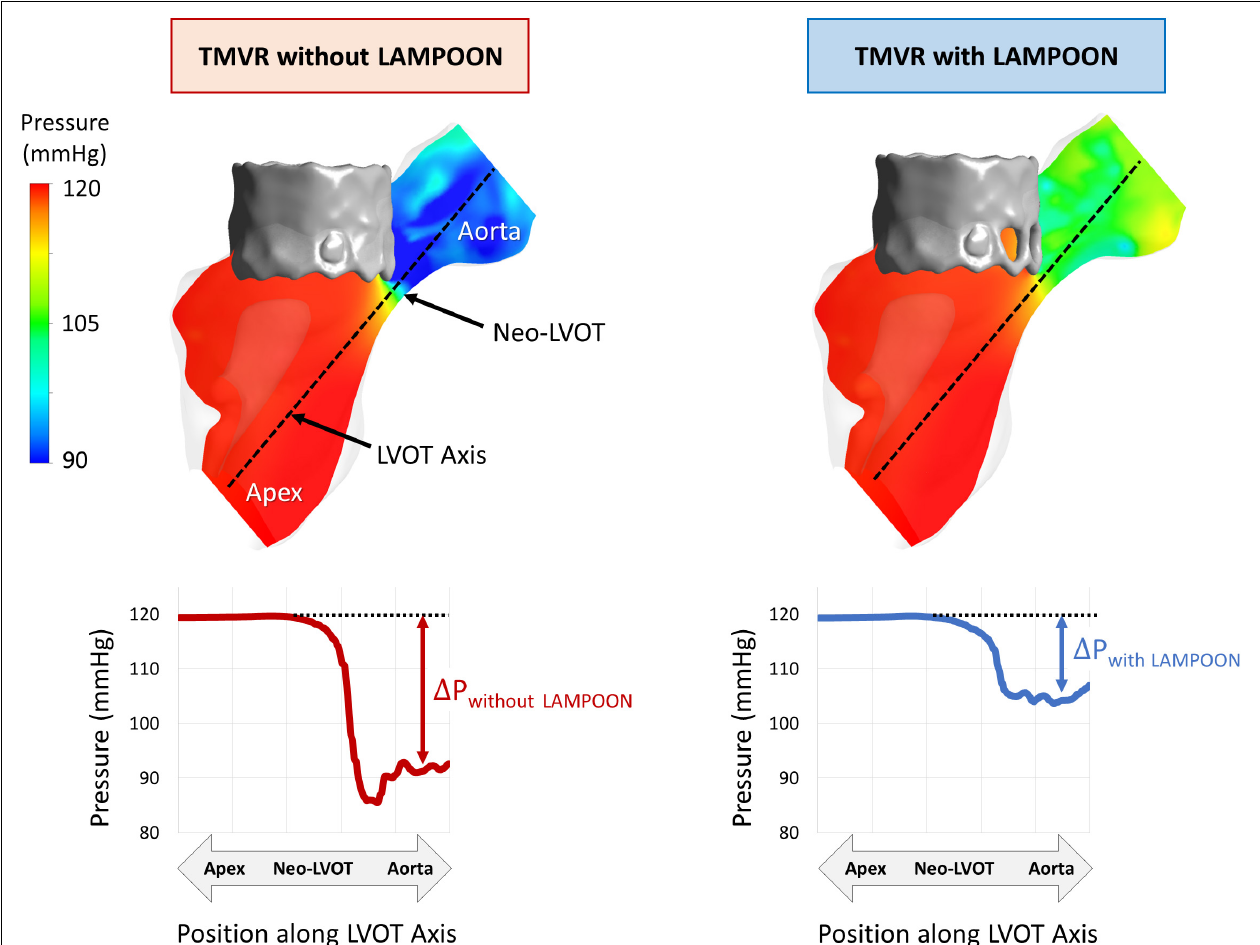
FIGURE 3 | Effect of LAMPOON on left ventricular pressure fields. Simulated pressure fields for a representative subject (Subject 5) are shown in color maps (red = highest pressure, blue = lowest pressure). The left column shows the simulated pressure drop at the LVOT for the virtual control procedure (TMVR without LAMPOON). The right column shows the simulated pressure drop at the LVOT for the actual performed procedure (TMVR with LAMPOON). The simulated LVOT gradient is substantially reduced following LAMPOON. In this subject, LAMPOON exposed three cells of the transcatheter valve, corresponding to a total increase in flow area of 87 mm 2